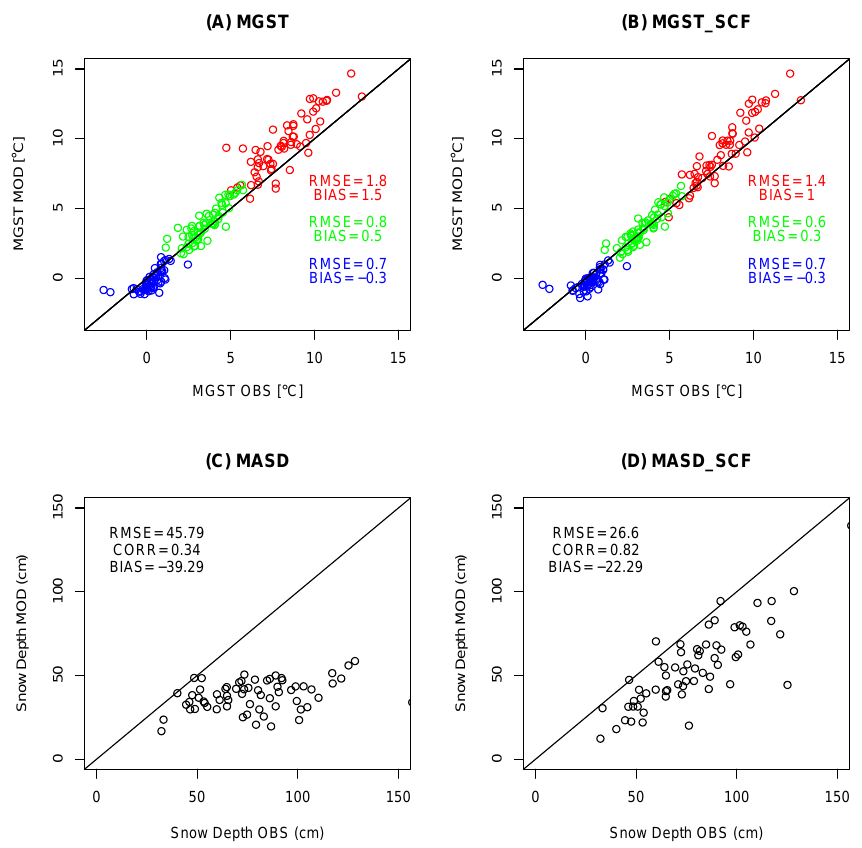
Figure 7. Ground surface temperature (a) without and (b) with SBC method evaluated at all available IMIS stations (64). Winter (blue) and summer (red) MGST, and MAGST (green) are shown. Negative bias is seen in winter and positive bias in summer. Annually the positive bias dominates due to greater magnitude of values. MASD (c) without and (d) with SBC method evaluated at the same stations. This shows the ability of the method to correct MASD, albeit while retaining a systematic